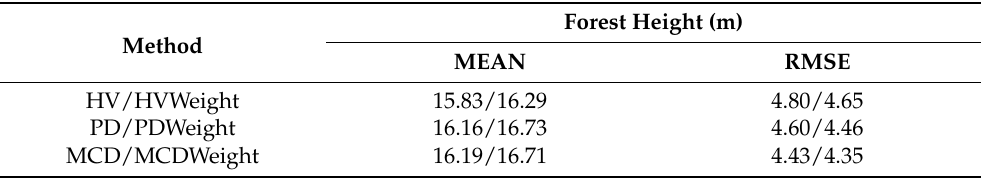
Table 3. Results of forest height